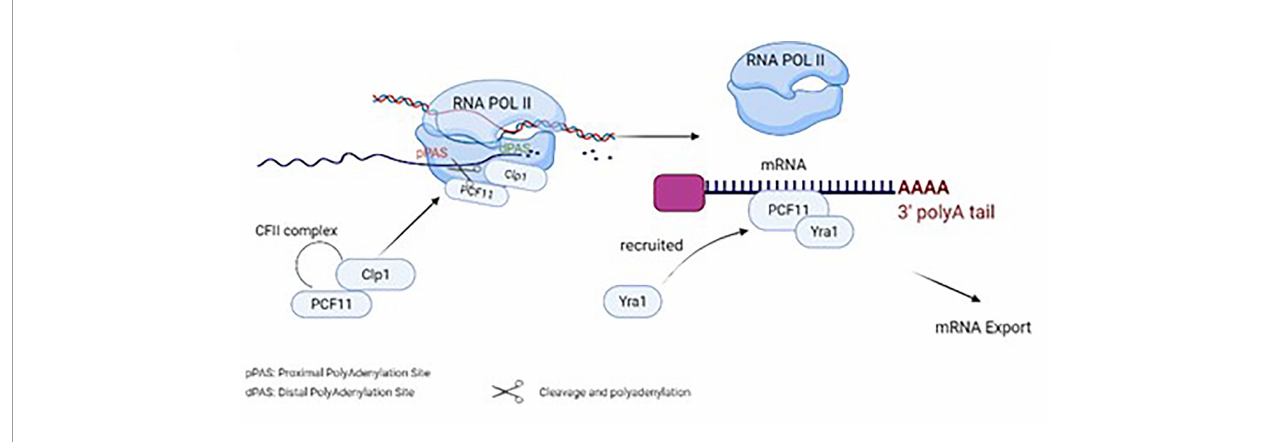
FIGURE 1 | Physiological functions of PCF11 in normal cells and its role in cleavage, polyadenylation, termination and mRNA export..